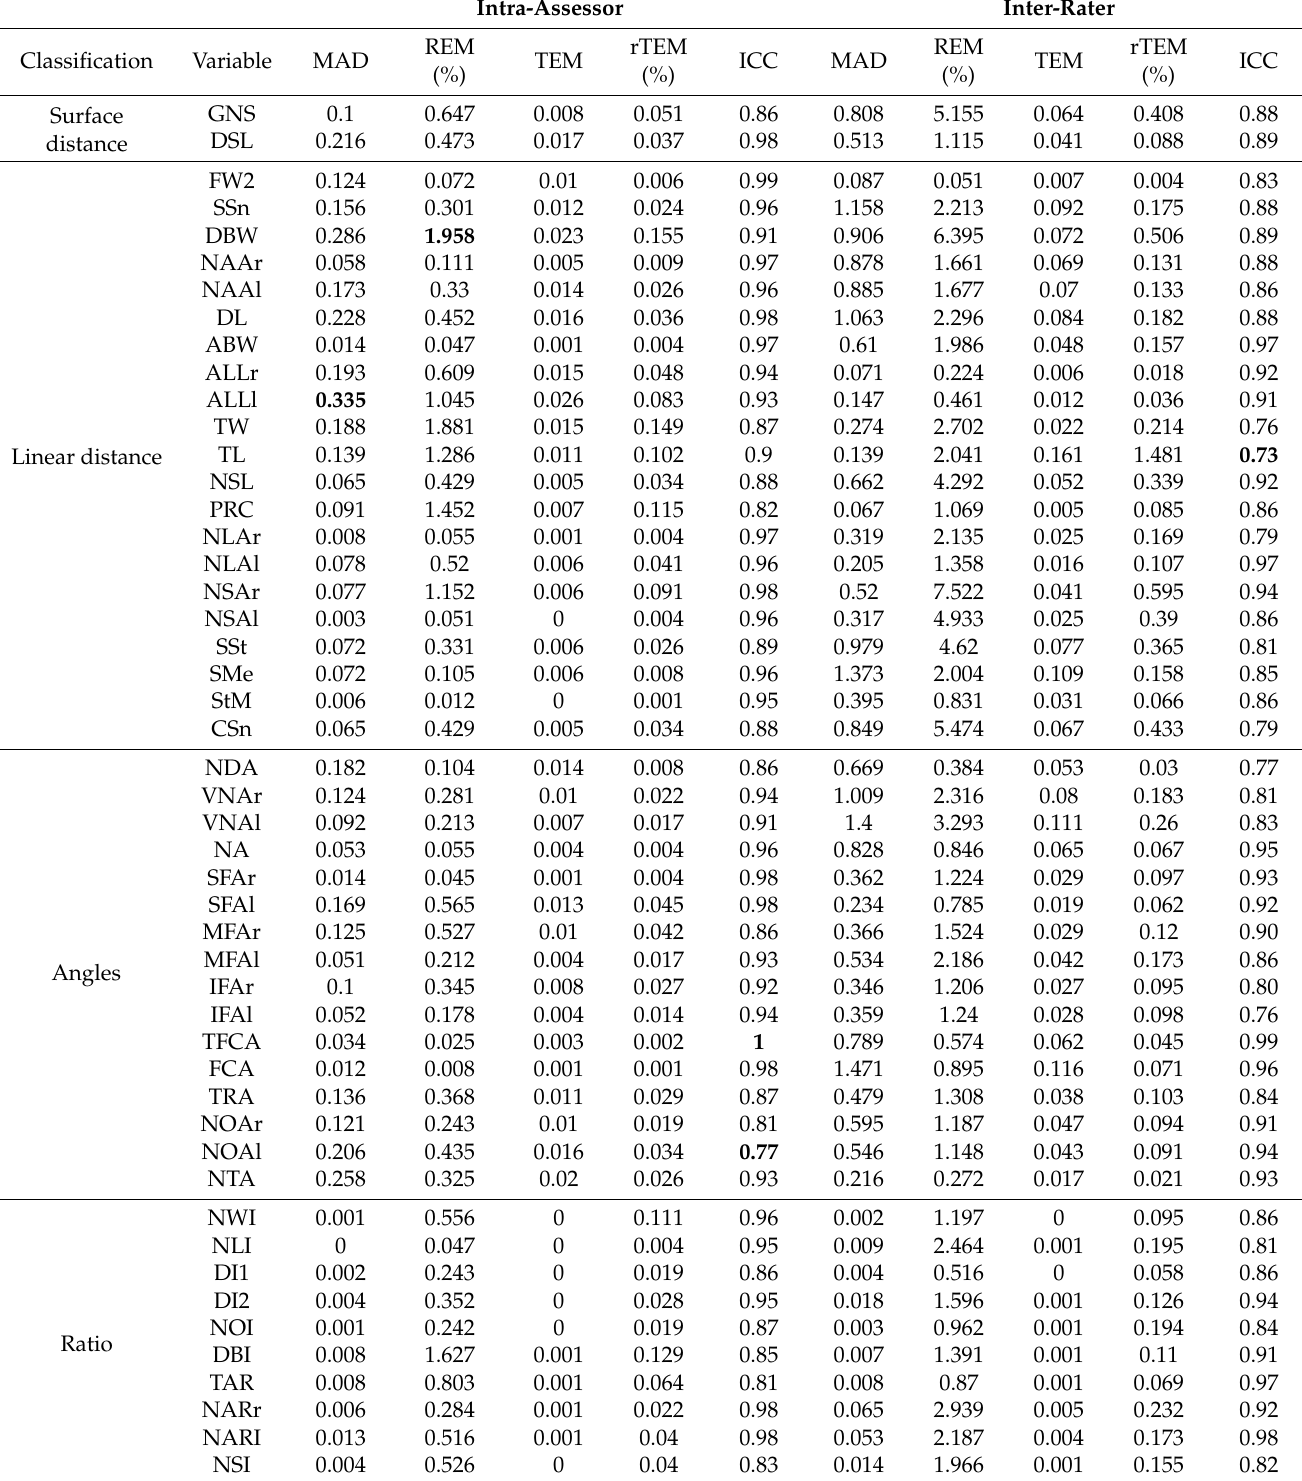
Table 6. The intra-assessor and inter-assessor reliability of novel parameters. Intra-Assessor